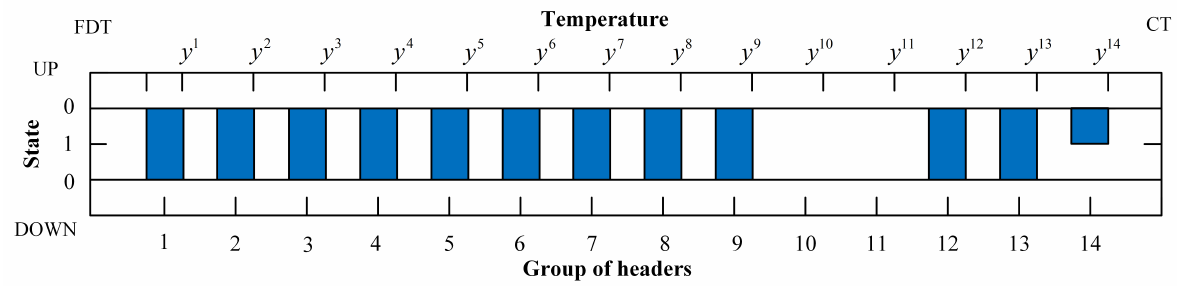
Figure 7. The initial state of spray header banks in LCP.